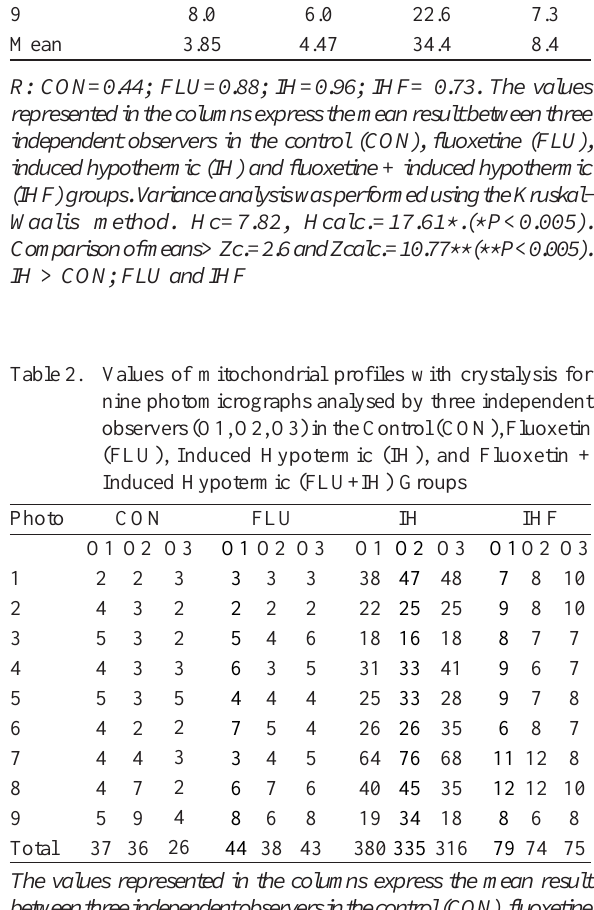
represented in the columns express the mean result between three independent observers in the control (CON), fluoxetine (FLU),